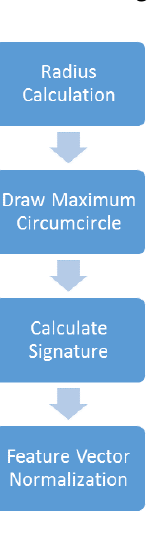
Figure 2. Depth CIPBR